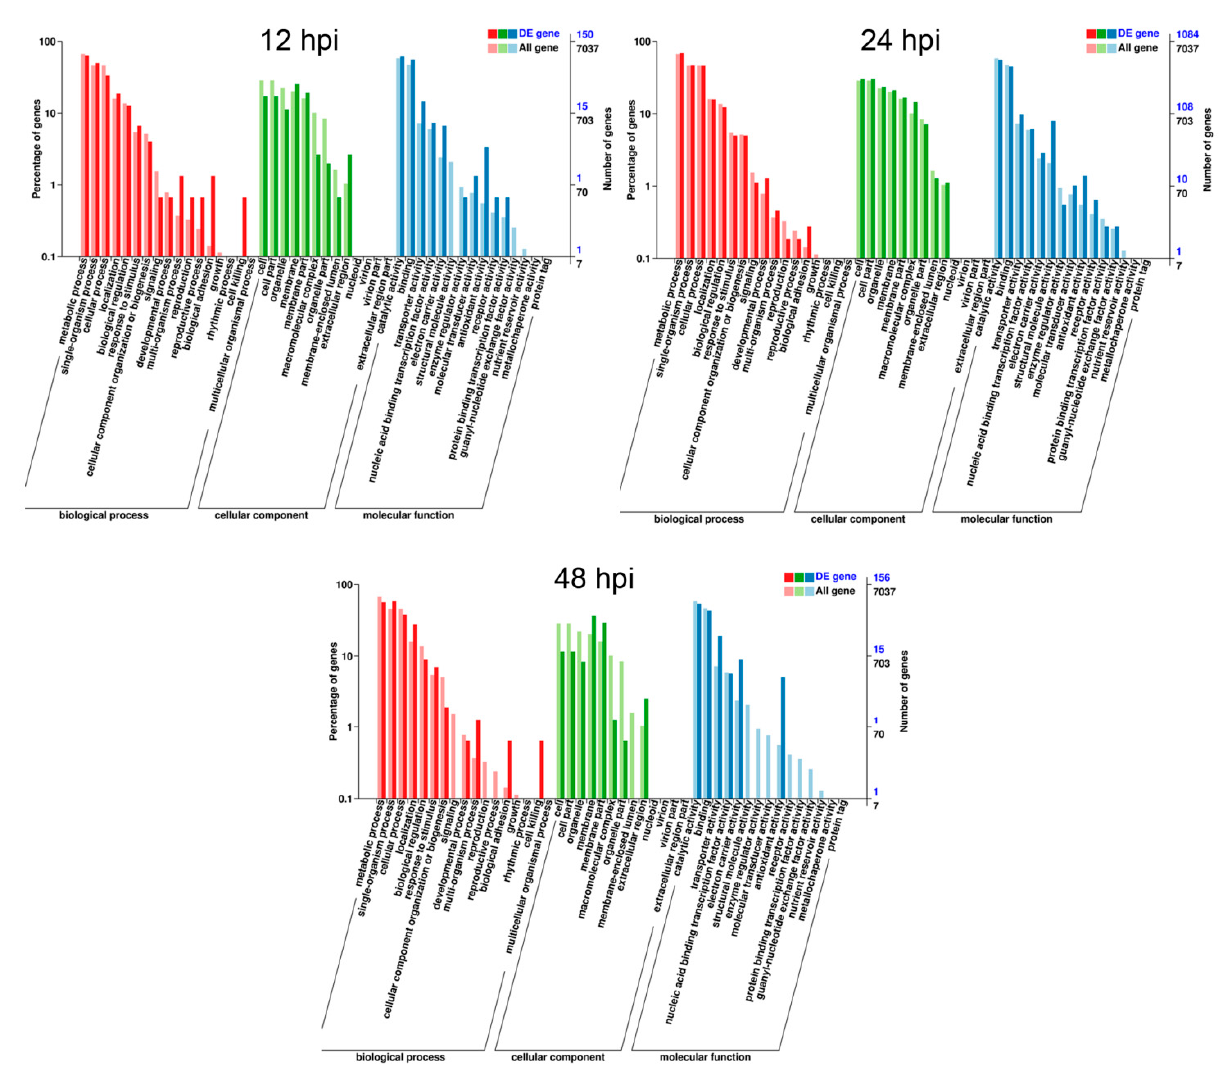
Figure 3. Gene ontology (GO) classifications of commonly induced genes at three time intervals after F. graminearum inoculation. Genes were annotated in three categories: cellular component (CC), molecular function (mf) and biological process (bp). All GO terms shown were significant at FDR ≤ 0.005.